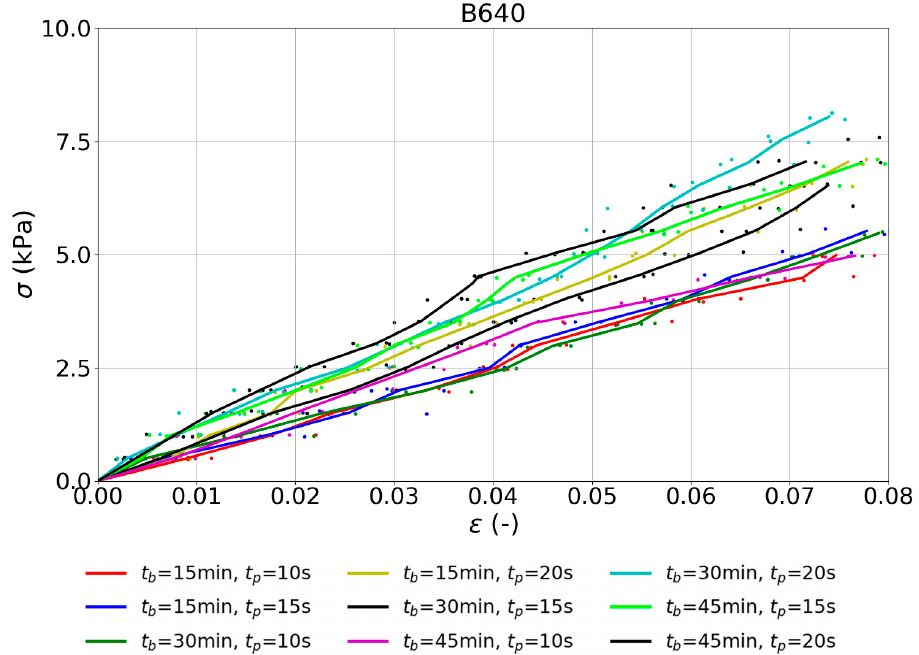
Figure 10. Stress–strain relations for mixes B640.